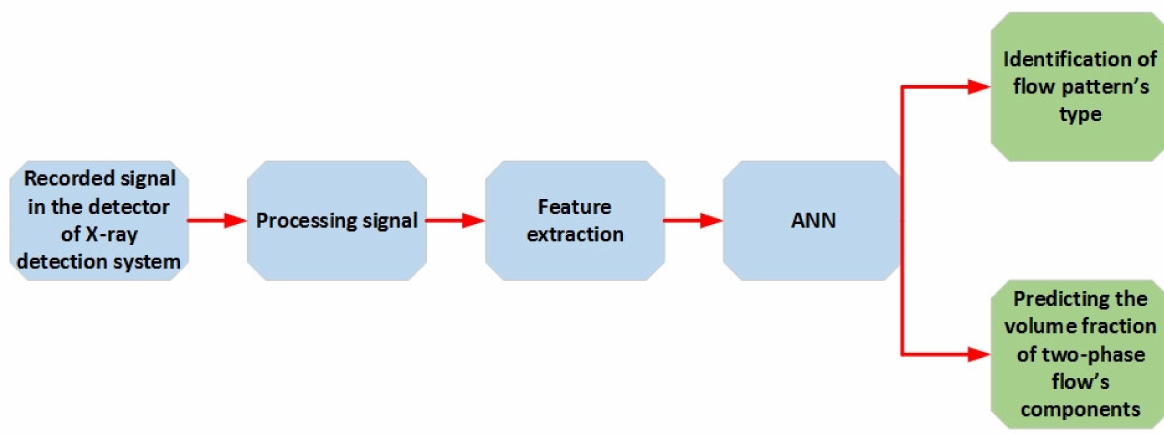
Figure 1. Flowchart of the presented methodology in this